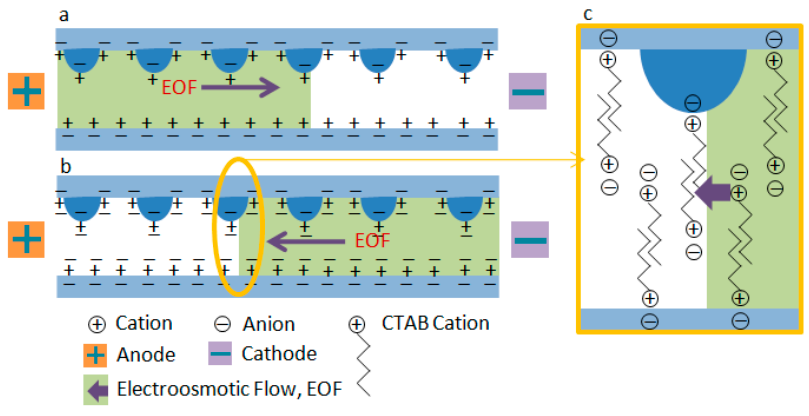
Figure 14. Schematic diagram showing the electroosmotic flow inside of the mixing channel on a PMMA chip. ( a ) Electroosmotic flow in the PMMA channel; ( b ) reversal of electroosmotic flow by addition of cationic surfactant CTAB to the buffer; ( c ) the bilayer formed inside the mixing channel.